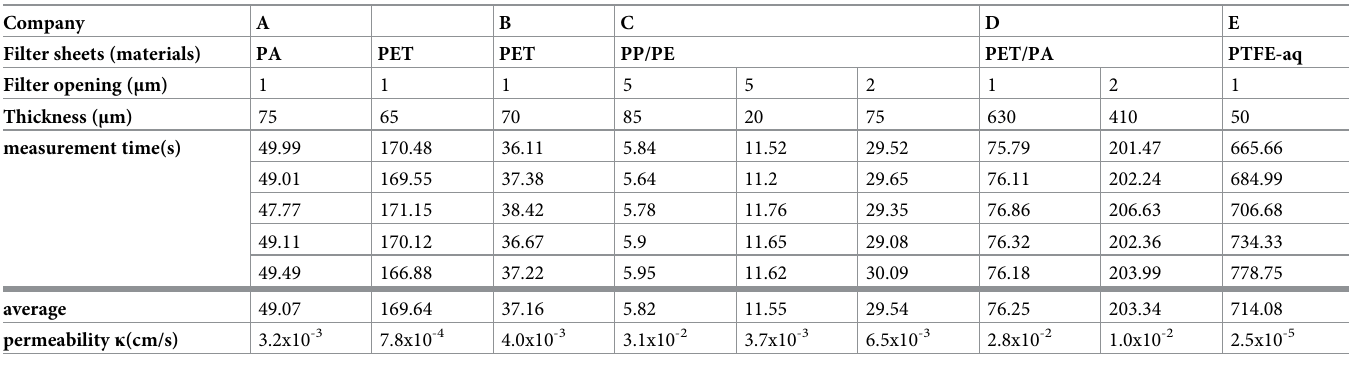
Table 1. Water permeability test.